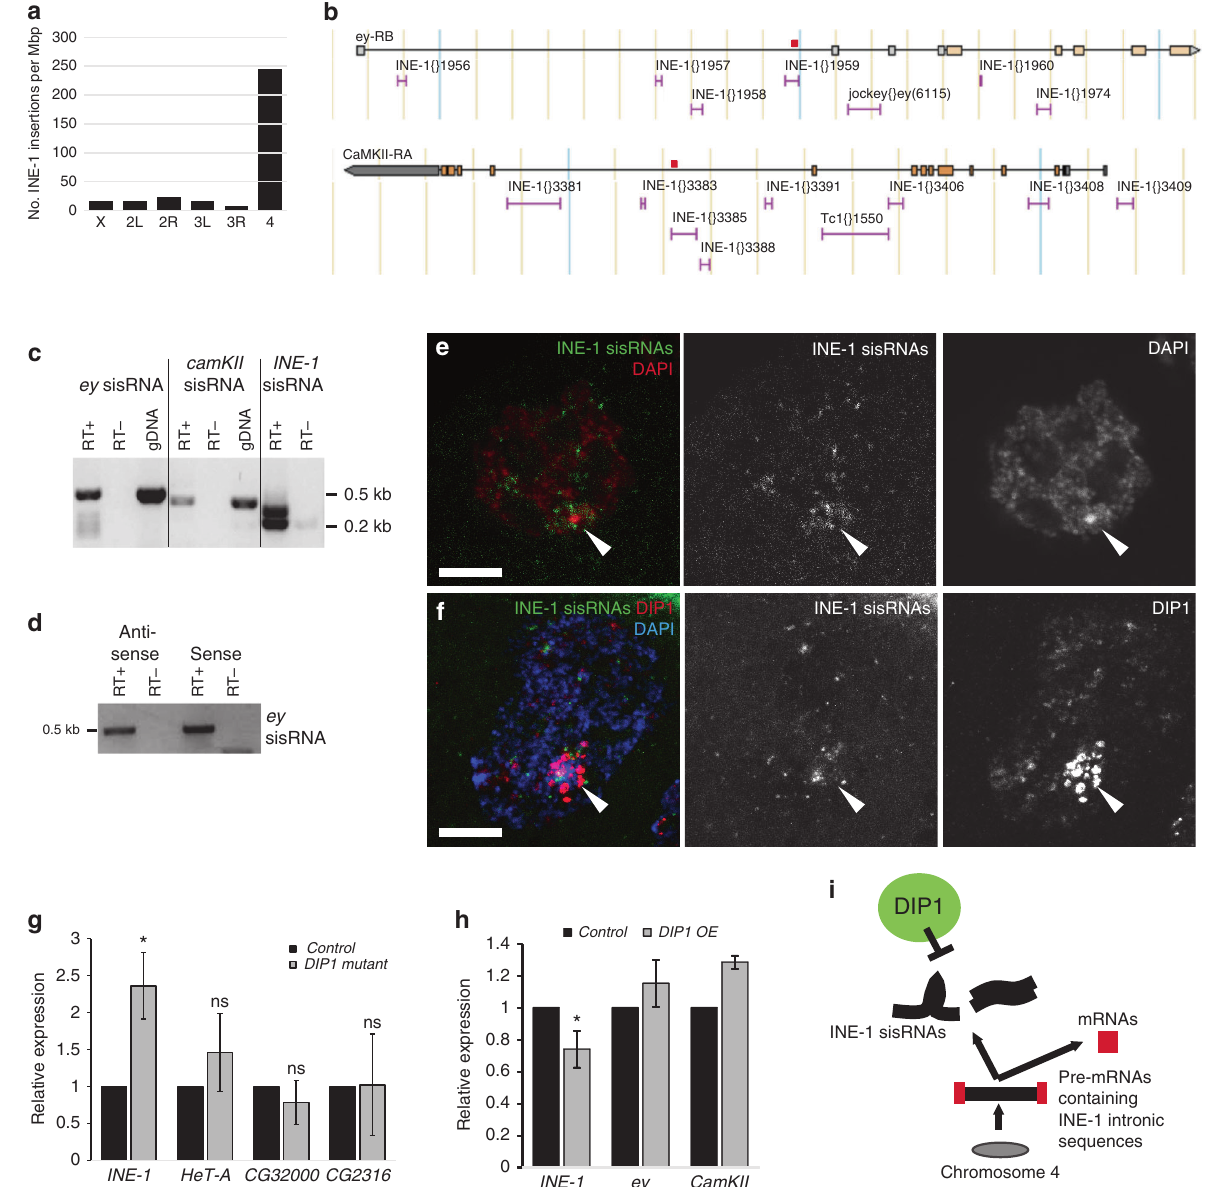
Fig. 6 DIP1 suppresses the level of INE-1 sisRNAs. a Chart showing the number of INE-1 insertions per Mbp of DNA on the different chromosomes in Drosophila melanogaster . b Genetic loci for eyeless ( ey ) and CamKII showing the location of INE-1 insertions in the introns. Red bars indicate the gene-speci fi c INE-1 sisRNAs ampli fi ed in c . c RT-PCR showing the presence of ey , CamKII and INE-1 sisRNAs in unfertilized eggs. gDNA, genomic DNA. d Strand-speci fi c RT-PCR showing the presence of both anti-sense and sense ey sisRNAs in unfertilized eggs. e Confocal images showing the localization of INE-1 sisRNAs ( Green ) and DAPI ( Red ) in a nurse cell nucleus. Arrowheads point to DAPI-dense regions of fourth chromosomes. f Confocal images showing the localization of INE-1 sisRNAs ( Green ), DIP1 ( Red ), and DAPI ( Blue ) in a nurse cell nucleus. Arrowheads point to DAPI-dense regions of fourth chromosomes. g RT-qPCR showing the relative levels of INE-1, HeT-A , CG32000 , and CG2316 in control and DIP1 mutant ovaries. h RT-qPCR showing the relative levels of INE-1, ey and CamKII in MTD-Gal4 control and MTD-Gal4 > HA-DIP1 ovaries. * P < 0.01. Two-tailed t -test. N = 3 independent biological replicates. Error bars represent s.d. i Working model on the role of DIP1-positive satellite bodies in regulating the abundance of INE-1 sisRNAs in